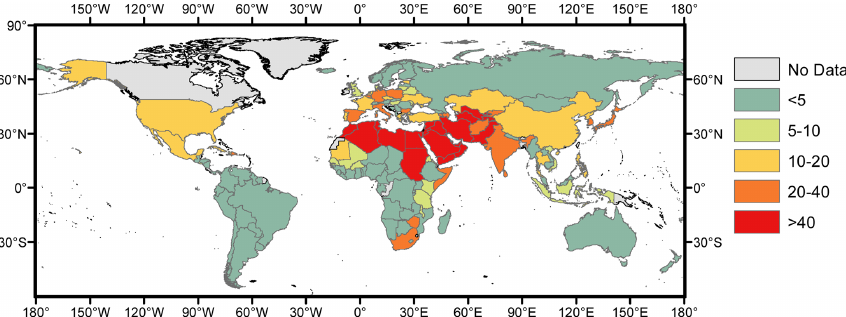
Figure A1. Proportion of total renewable water resources used by country (data source: Food Agricultural Organization (FAO) of the United Nations;